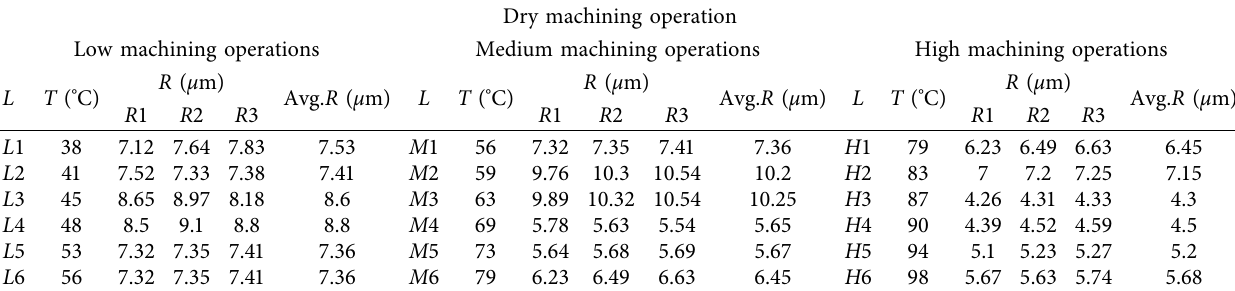
Table 8: Surface roughness ( R ) of dry machining operation.